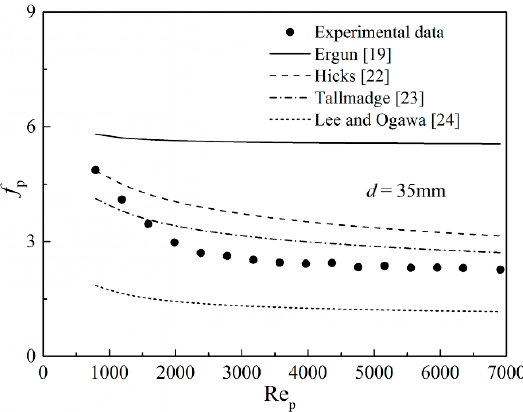
Figure 4. Comparison between the experimental data and the calculation values of f p for d = 35 mm.